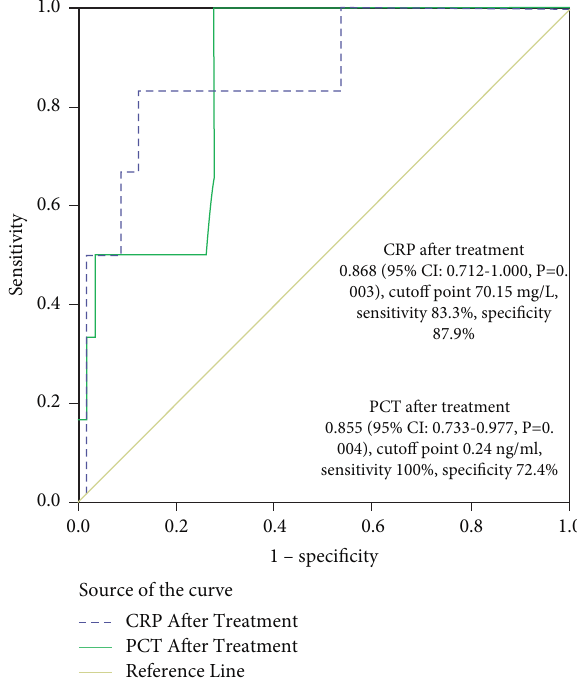
Figure 5: In order to identify the risk for death, we calculated the AUC of CRP and PCT after treatment which were 0.868 (95% Cl: 0.712–1.000, p � 0 . 003) and 0.855 (95% Cl: 0.733–0.977, p � 0 . 004) with cutoff values being 70.15 mg/L and 0.24ng/ml, respectively. The sensitivity/specificity was 83.3%/87.9% and 100%/72.4%,